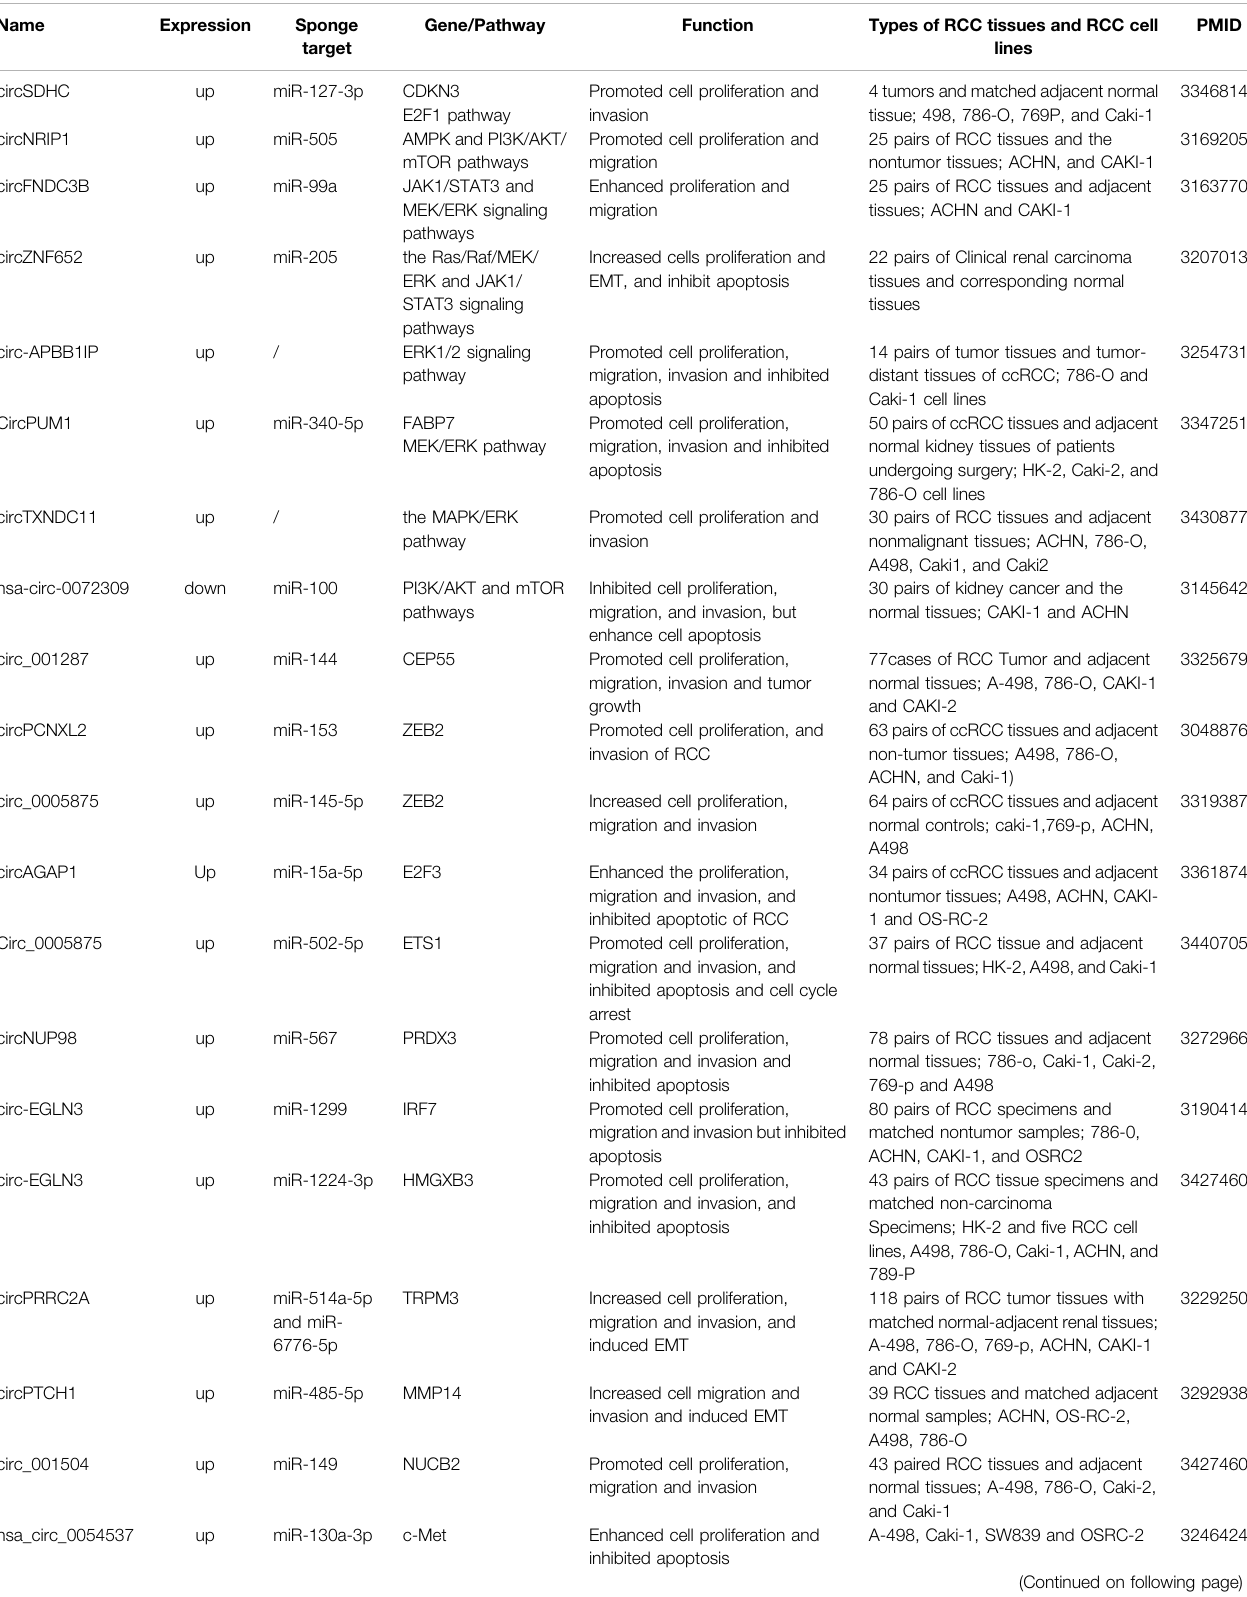
TABLE 1 | Dysregulated circRNAs in renal cell carcinoma (RCC).